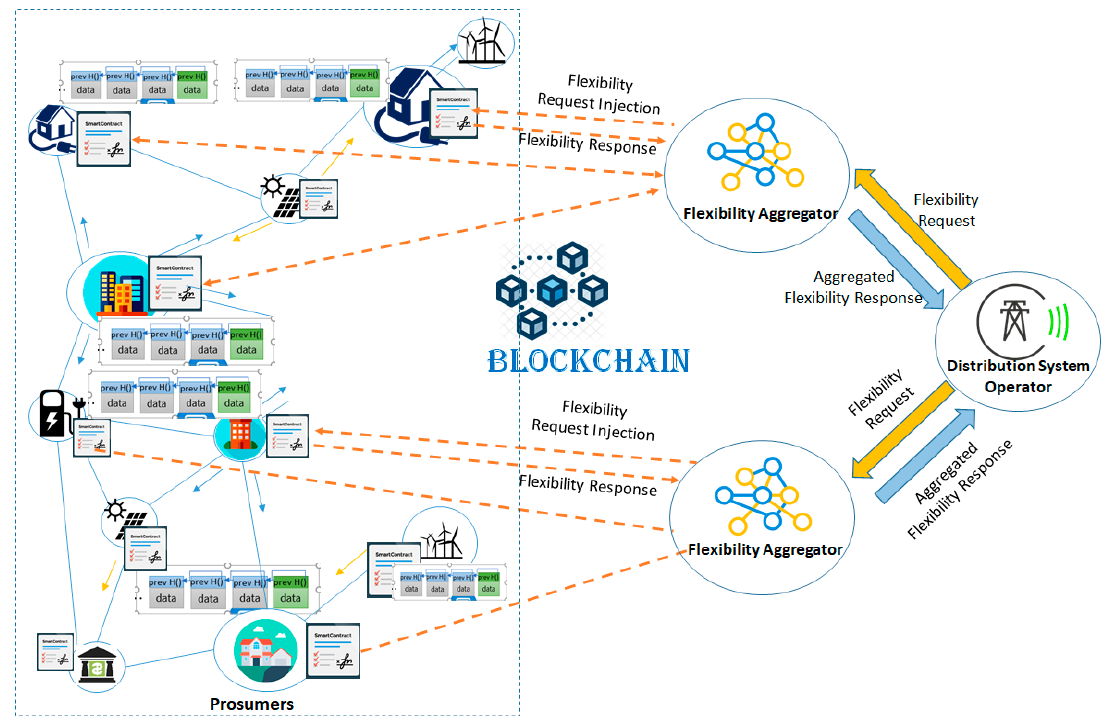
Figure 1. Flexibility based DR programs implementation using blockchain and smart contracts.